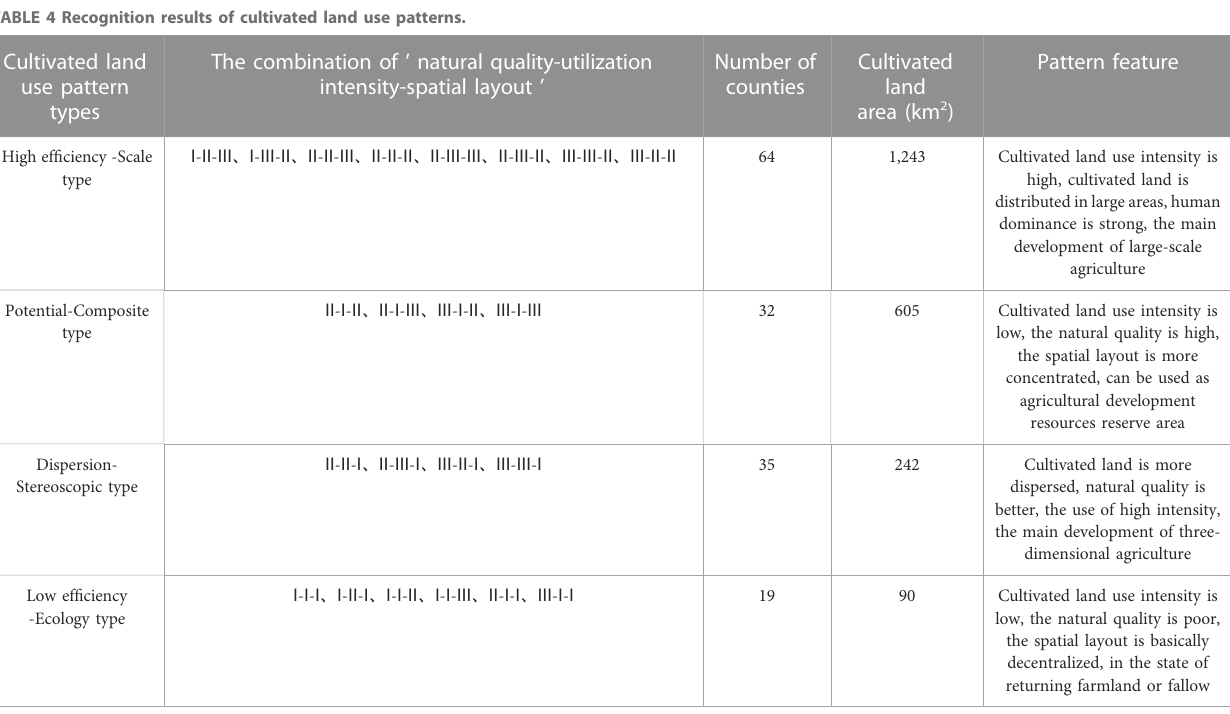
TABLE 4 Recognition results of cultivated land use